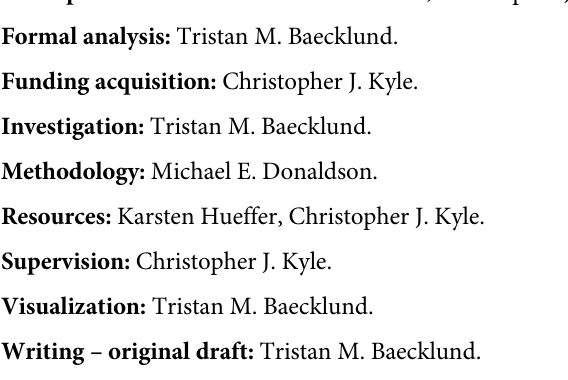
S6 Table. Pairwise F 97.5% upper and lower confidence intervals. Outlines the pairwise ST F intervals between the three sampled regions. Interval pairs that were significantly different ST from zero are bolded. S7 Table. Comparison of genes under selection based on pN/pS ratios for each sampling region. For each gene highlights the ratio of non-synonymous substitutions per non-synony- mous site (pN) to synonymous substitutions per synonymous site (pS) across the three sam- pled regions, as well as a test of significance using the Chi squared p-values. Bolded ratios indicated those pN/pS ratios greater than or equal to 1 suggestive of directional selection and those pN/pS ratios that have statistically significant p values. Polymorphic sites were deter- mined using SnpEff and potential nonsynonymous/synonymous sites were determined using the coding sequence for each gene as input for DnaSP v6. (Rozas et al. 2017 [68]). (XLSX) S1 File. Supplementary methods. Additional methods pertaining to linkage disequilibrium pruning and the F outlier testing program parameters ST